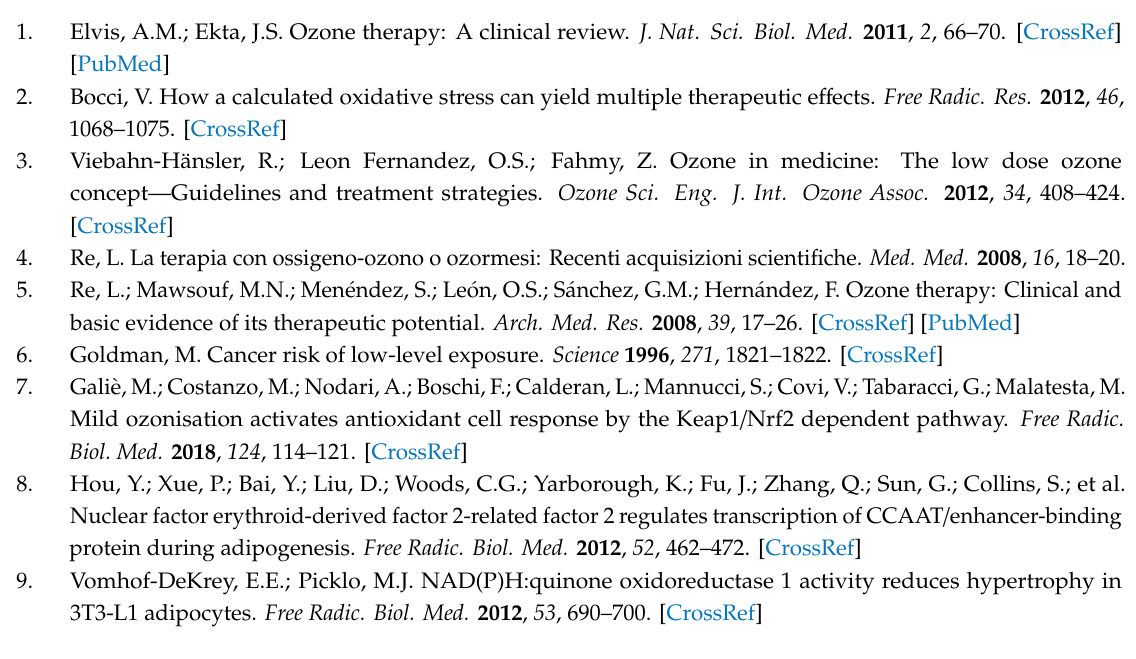
Figure S1. SEM ( A ) and TEM ( B ) micrographs of adipocytes after 2 h from treatment with 100 µ g O 3 ; Figure S2. Representative NMR spectra recorded on culture media after 2 h (green), 24 h (magenta) and 48 h (blue) from gas treatment; Figure S3. NMR-based metabolomic analysis of culture medium samples; Table S1. Coe ffi cient of variation (CV% = standard deviation / mean × 100) for each metabolite analysed ( n =